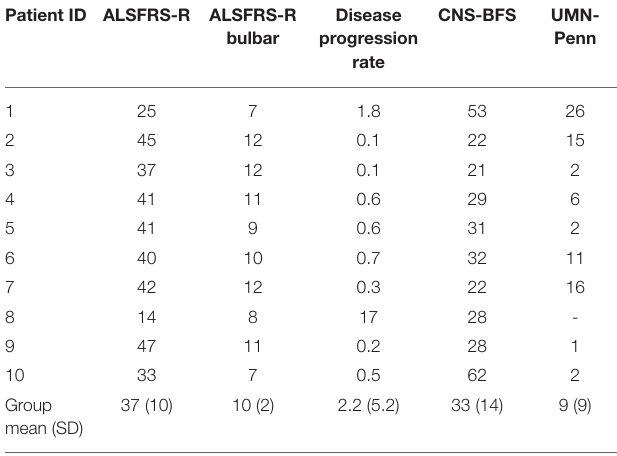
TABLE 3 | Clinical scores of patients with